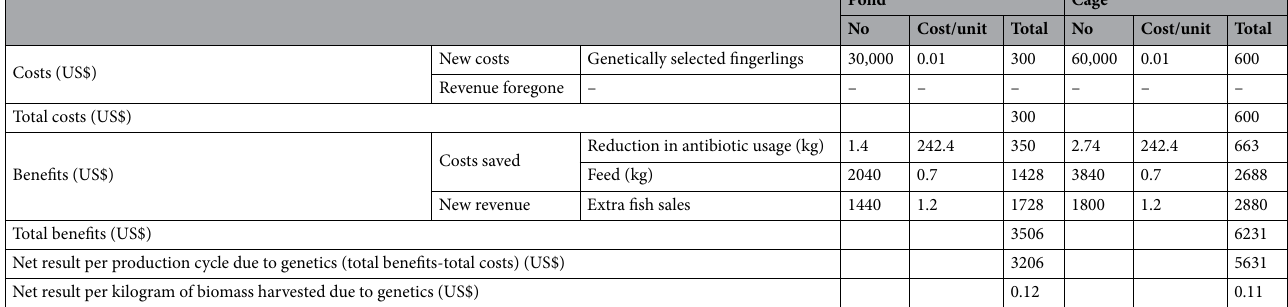
Table 3. Partial budget for genetically selected Nile tilapia fingerlings resistant to Streptococcosis, considering one production cycle of tilapia farming in the pond system (starting with 30,000 fingerlings) and the cage system (starting with 60,000 fingerlings) using deterministic approach.